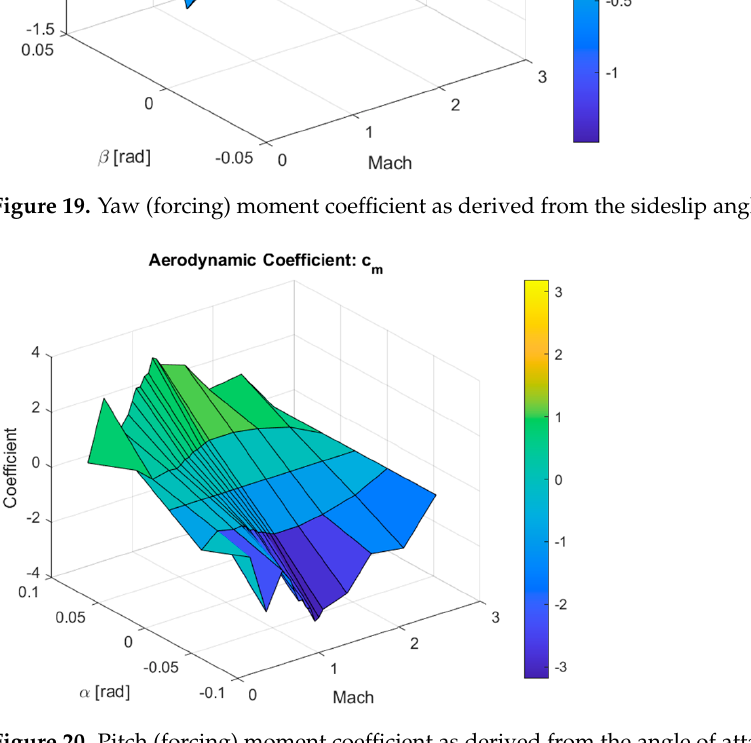
Figure 20. Pitch (forcing) moment coefficient as derived from the angle of attack and Mach num- ber.